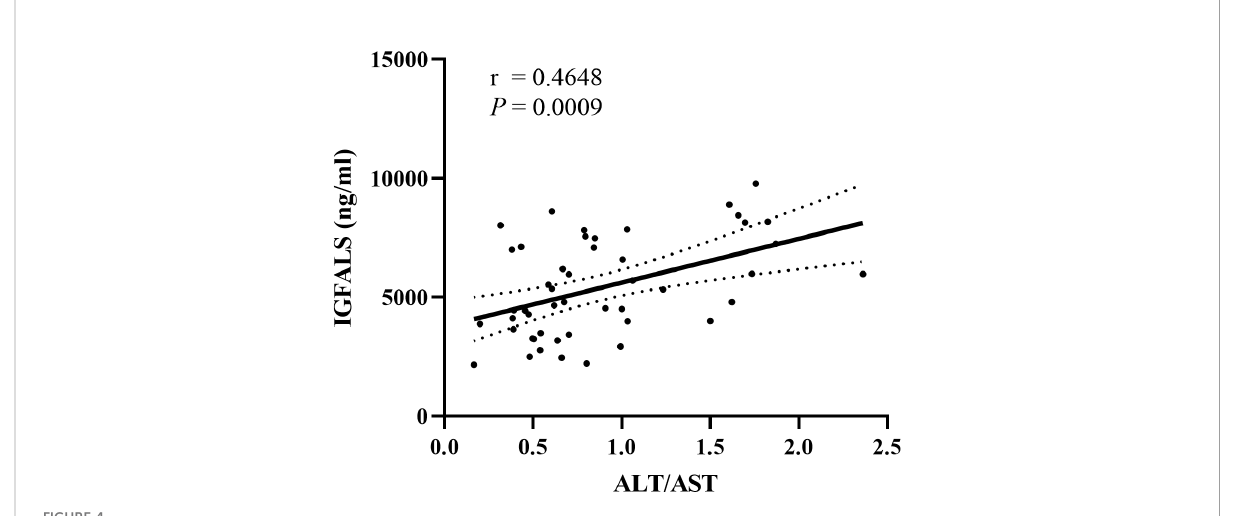
FIGURE 4 Correlation between IGFALS expression with ALT/AST in ALD patients. Pearson correlation coef fi cient of IGFALS is r=0.4648 ( P =0.0009) showing a positive correlation with ALT/AST represented by enrolled